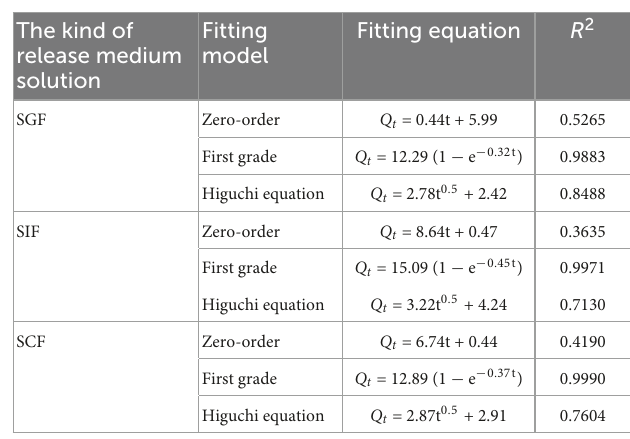
TABLE 3 Fitting results of KS/NM gel spheres for different models release behavior at SGF, SIF, and